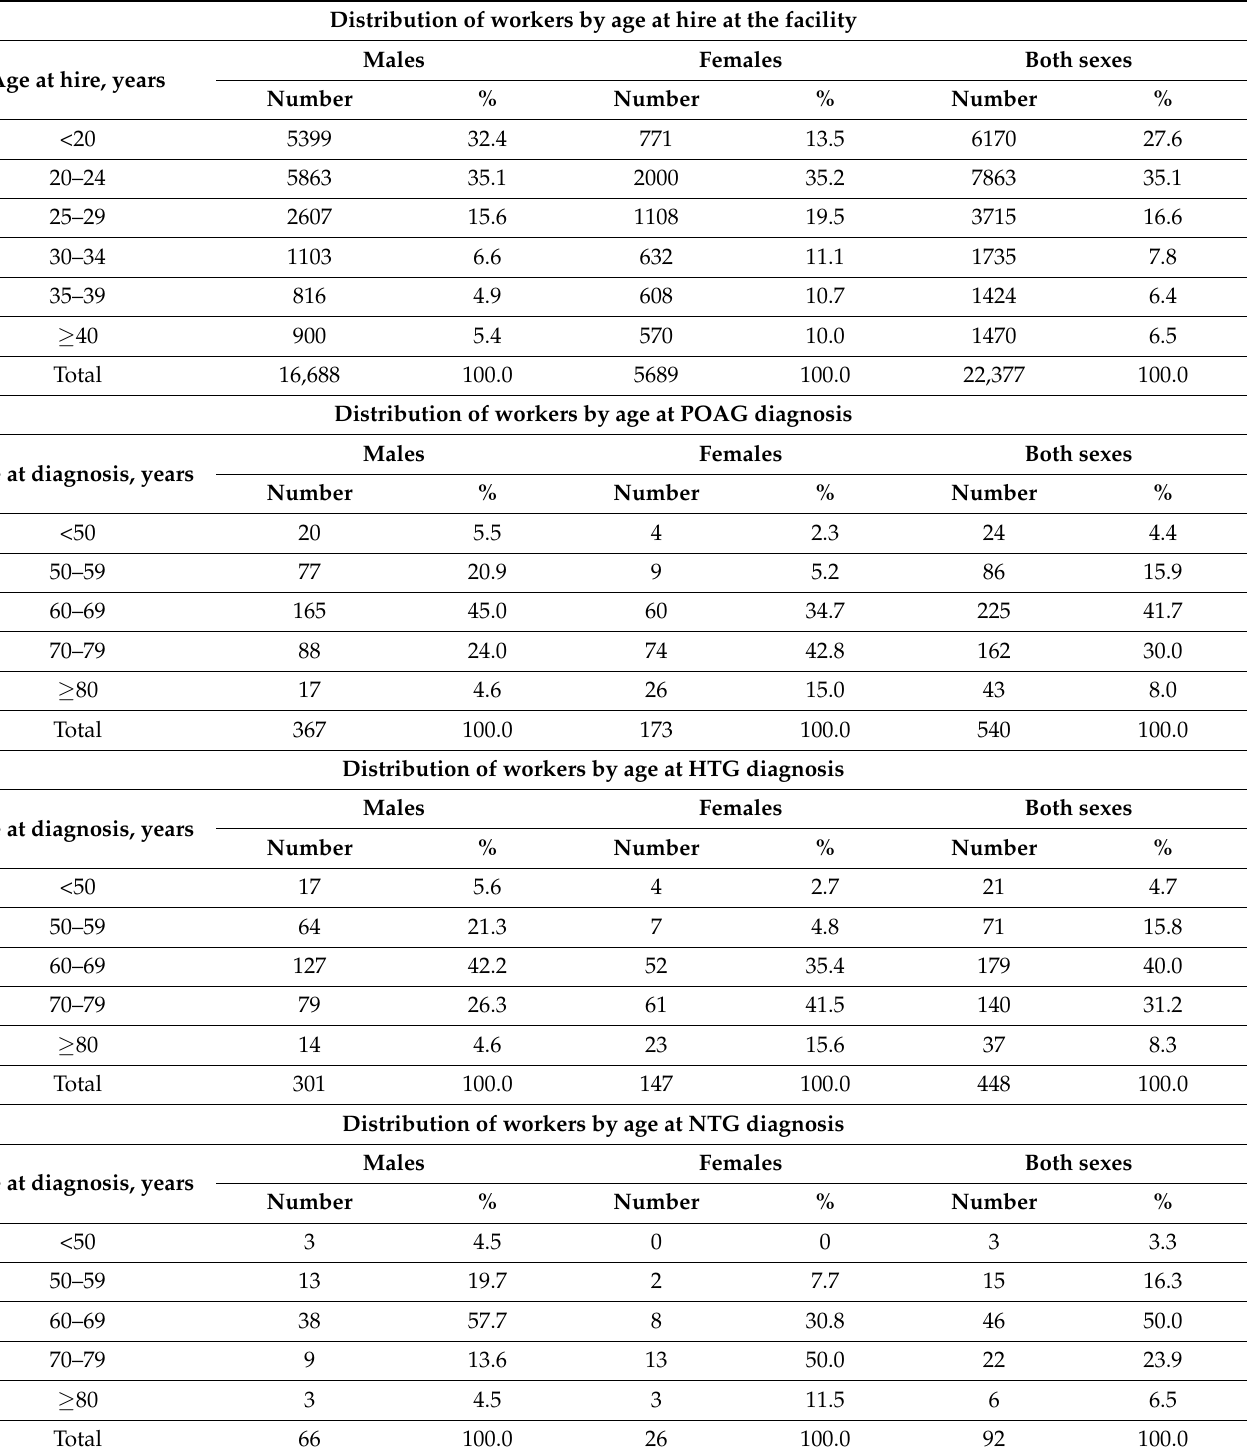
Table 1. Characteristics of the study